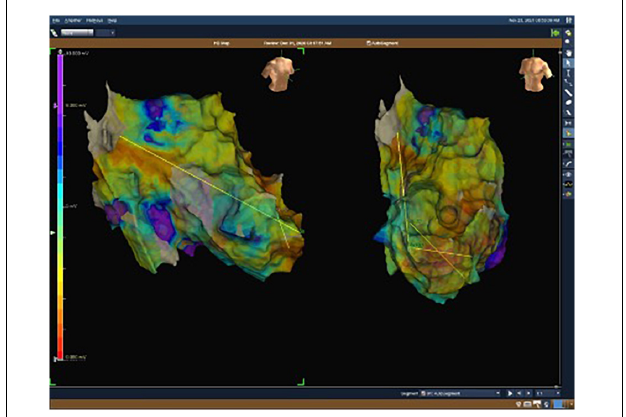
FIGURE 2 | Electroanatomical map with unipolar (UV) voltage of the second patient. UV range from 0.05 mV (red color) to 8.3 mV (purple color).